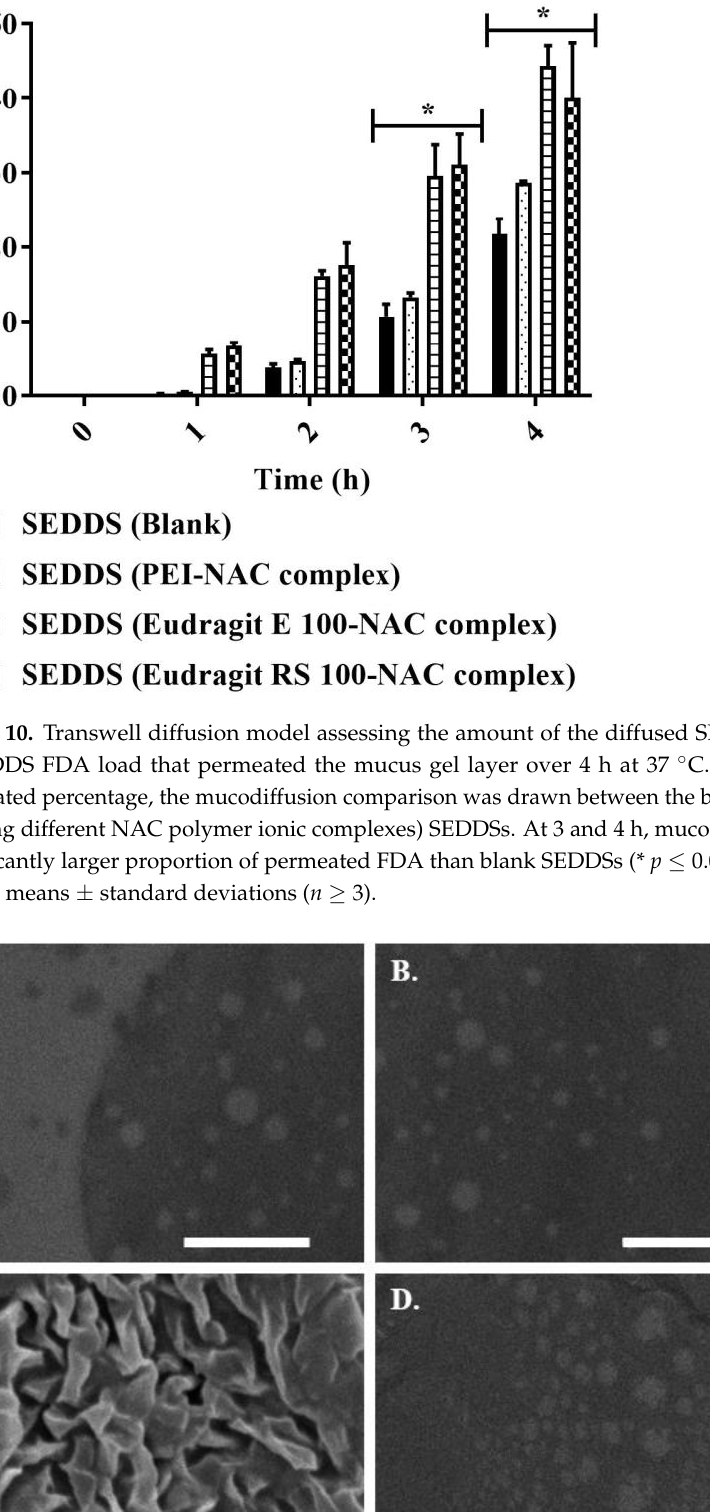
Figure 12. After 4 h of washing with 0.1 M phosphate buffer (pH 6.8) and incubation at 37 °C, the quantity of SEDDSs residing in porcine intestinal mucosal slices was measured using a 45° angle. *** p ≤ 0.001 versus a blank SEDDS. Indicated values are the means ± standard deviations ( n ≥ 3). 4. Conclusions The size (<100 nm), PDI (<0.3), and zeta potential (average = −7 .72 mV) stability among the produced mucoactive SEDDSs containing NAC polymer ionic complexes were all preserved in this study. The resazurin assay, which showed >85% cell viability, validated biocompatible and non-toxic SEDDS concentrations when applied on Caco-2 cells at 1% and 3% dilutions. SEDDSs demonstrated that NAC leaking out of droplets